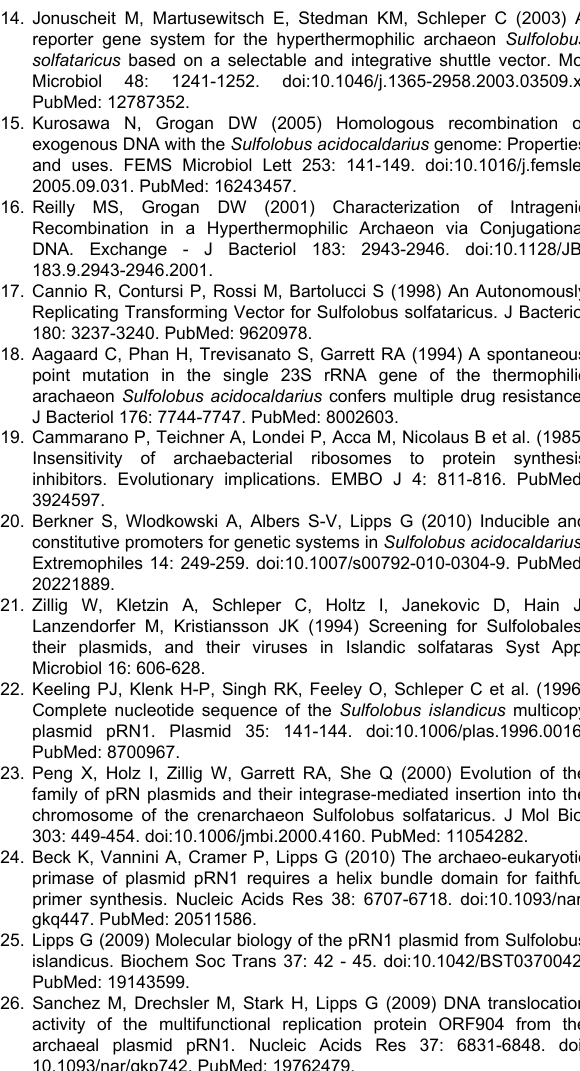
Table S1. Description of primers used in plasmid